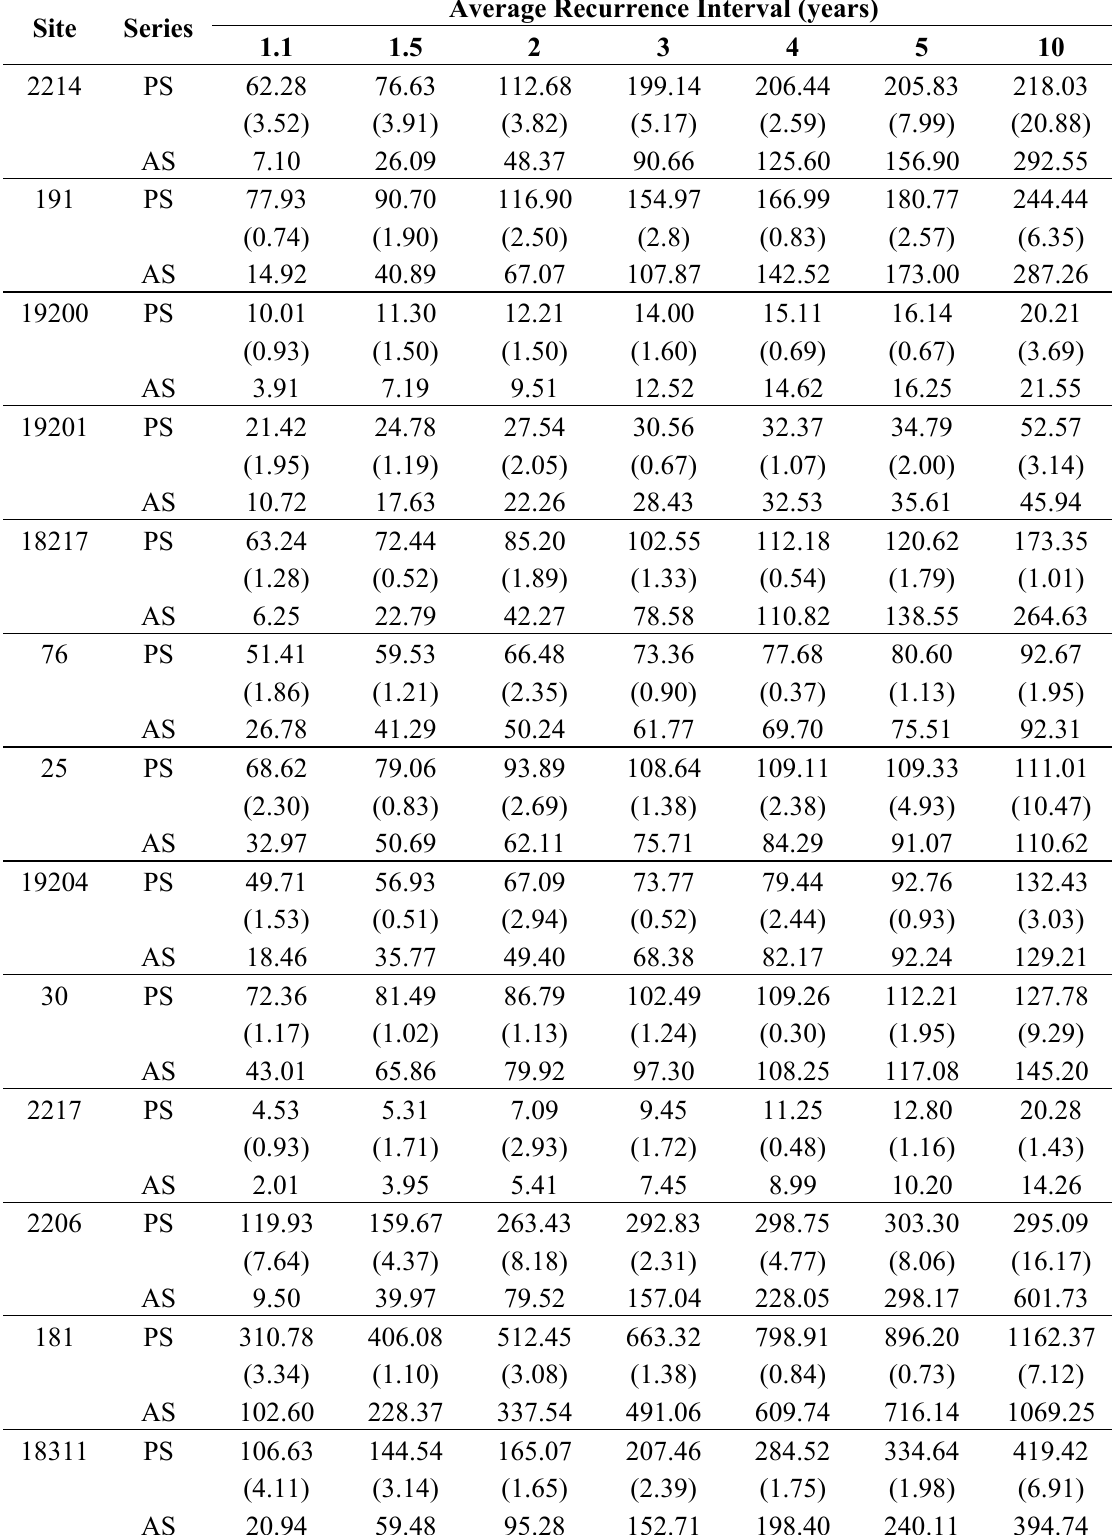
Table 2. Estimated discharge (m 3 s − 1 ) for 1.1, 1.5, 2, 3, 4, 5 and 10 year average recurrence interval floods using partial (PS) and annual series (AS) data for Northern Tasmanian stream gauging stations (Coefficient of variation for partial series estimates PS and PS shown in 2.5